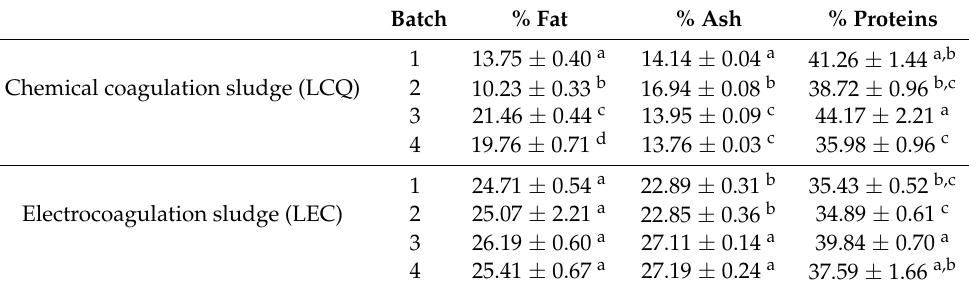
Table 1. Proximate composition (dry basis) of sludge flour from PW.